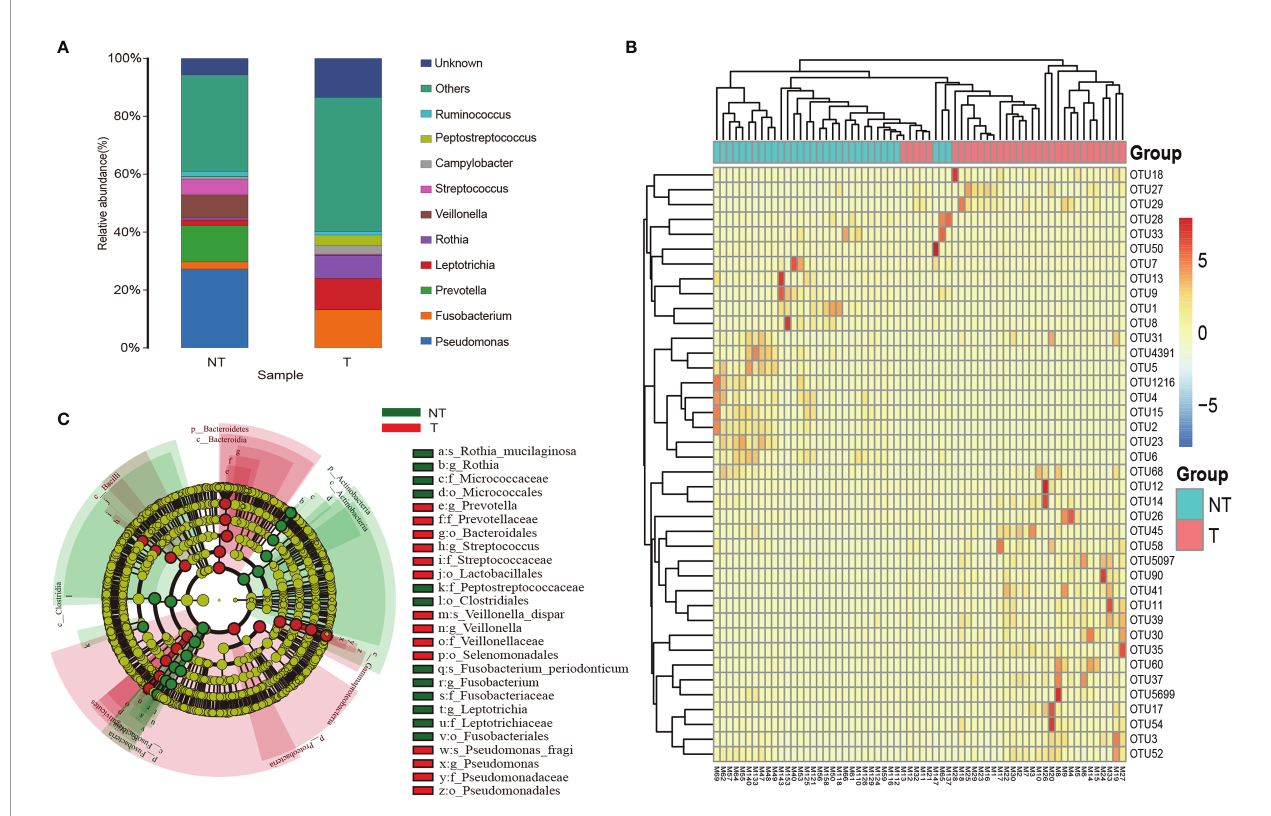
FIGURE 5 | Taxa characteristics of tumor and non-tumor regions. (A) Species distribution histogram. Color represents species, and the length of the color block represents relative abundance ratio of the species. (B) Heat maps of the two groups of bacteria. (C) The circle radiating from inside to outside represents the classi fi cation from phylum to genus level. Each small circle represents a classi fi cation at that level in different classi fi cation levels. The diameter of the small circle is proportional to the relative abundance. c_ is class, o_ is order, f_ is family, and g_ is genus; T, pulmonary segments with tumor; NT, pulmonary segments without